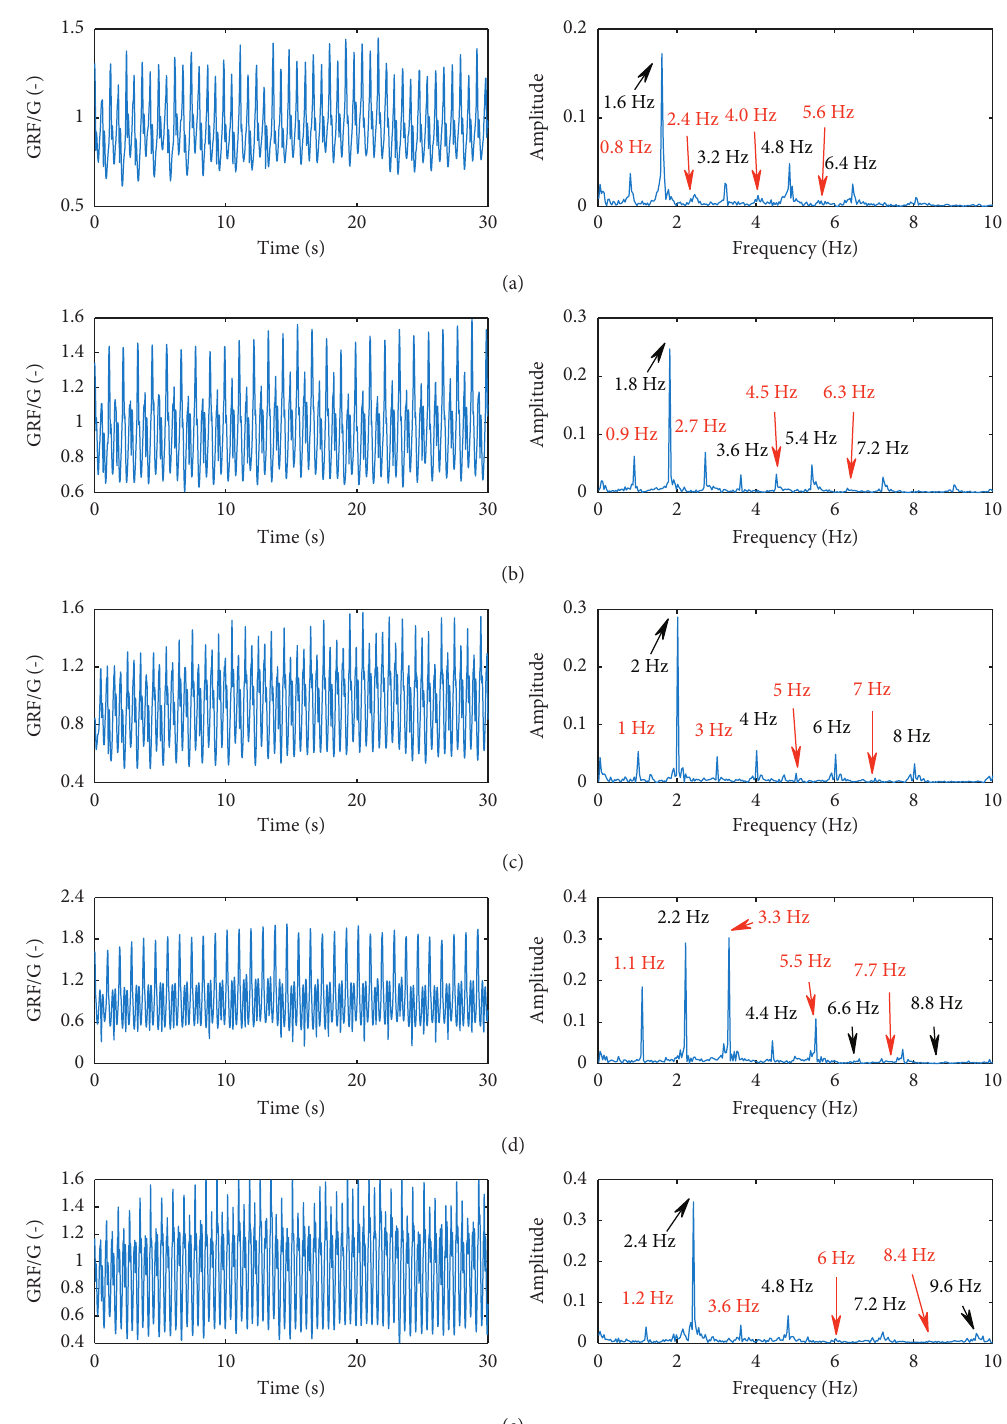
Figure 17: Vertical GRF for a single-person walking at step frequencies of (a) 1.6 Hz, (b) 1.8Hz, (c) 2.0 Hz, (d) 2.2Hz, and (e) 2.4 Hz in time and frequency